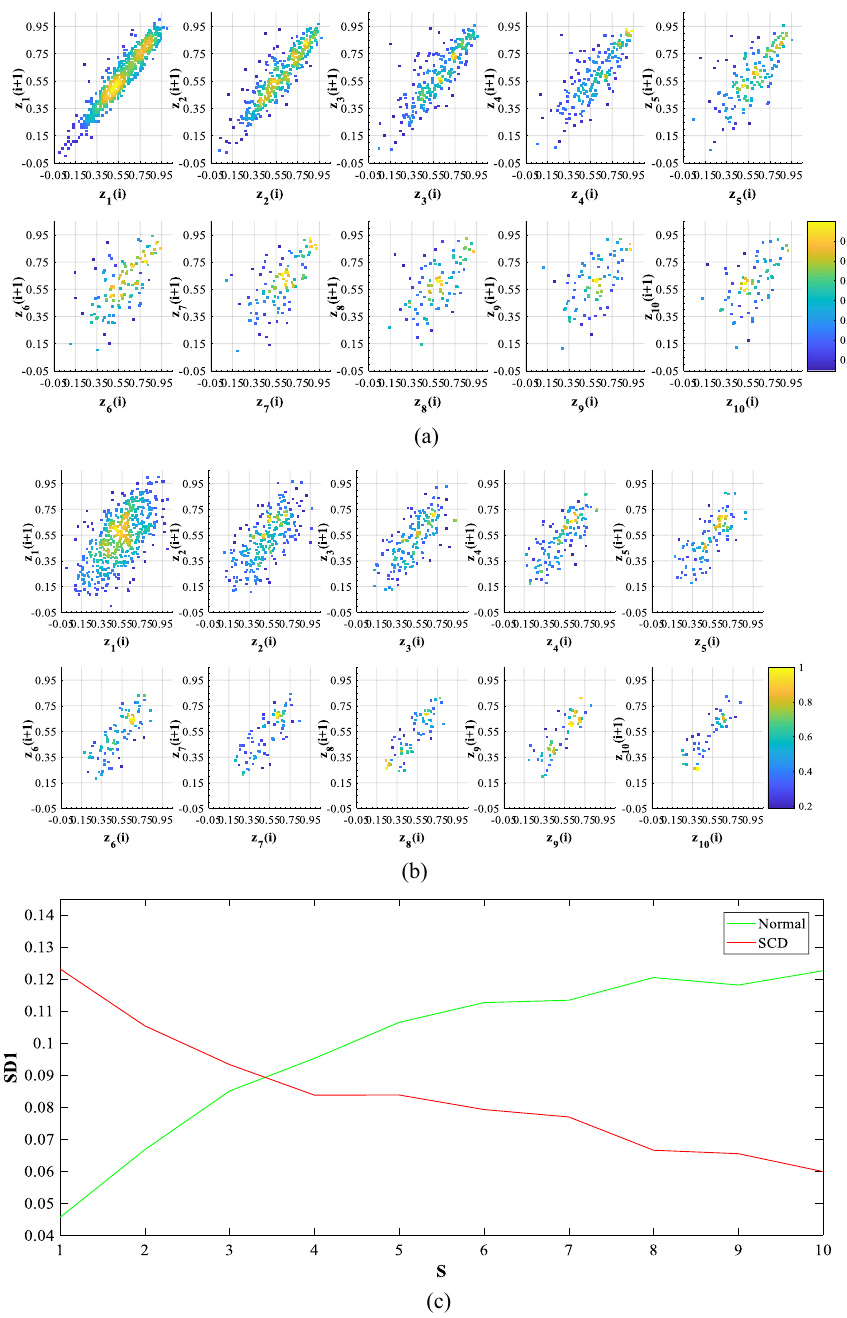
Fig. 4 a Multiscale Poincare plots of normal people (The data is from 16:13:49 to 16:23:49 of record No.19093 in Normal Sinus Rhythm database); b Multiscale Poincare plots of SCD patients (The data is from 12: 04: 56 to 12: 14: 56 of record No.35 in SCD database); c SD1 at each scale in ( a ) and ( b